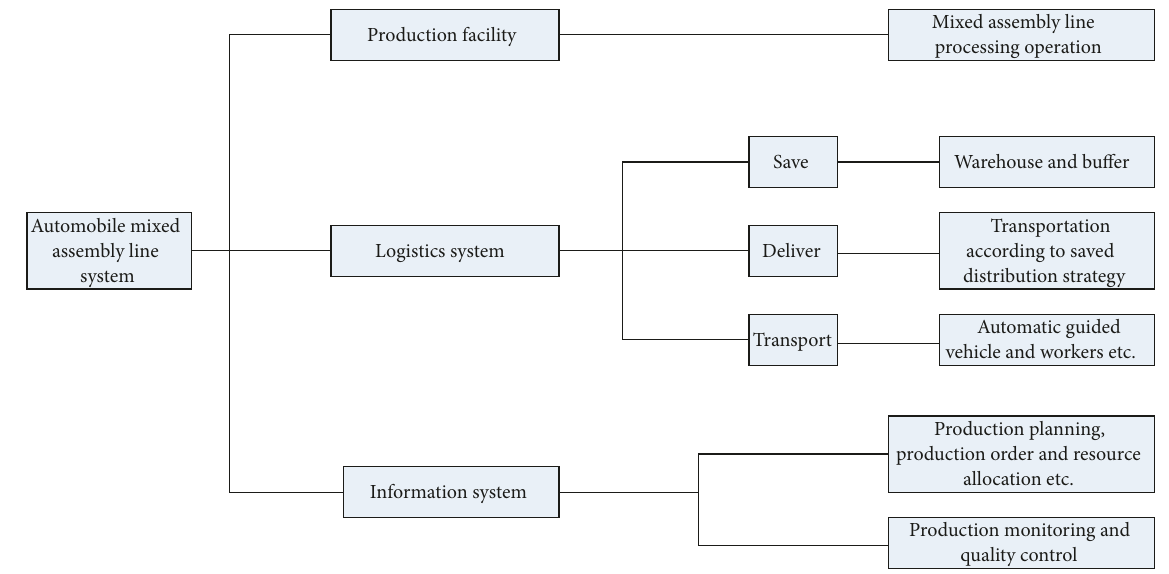
Figure 1: The composition of automobile mixed assembly line